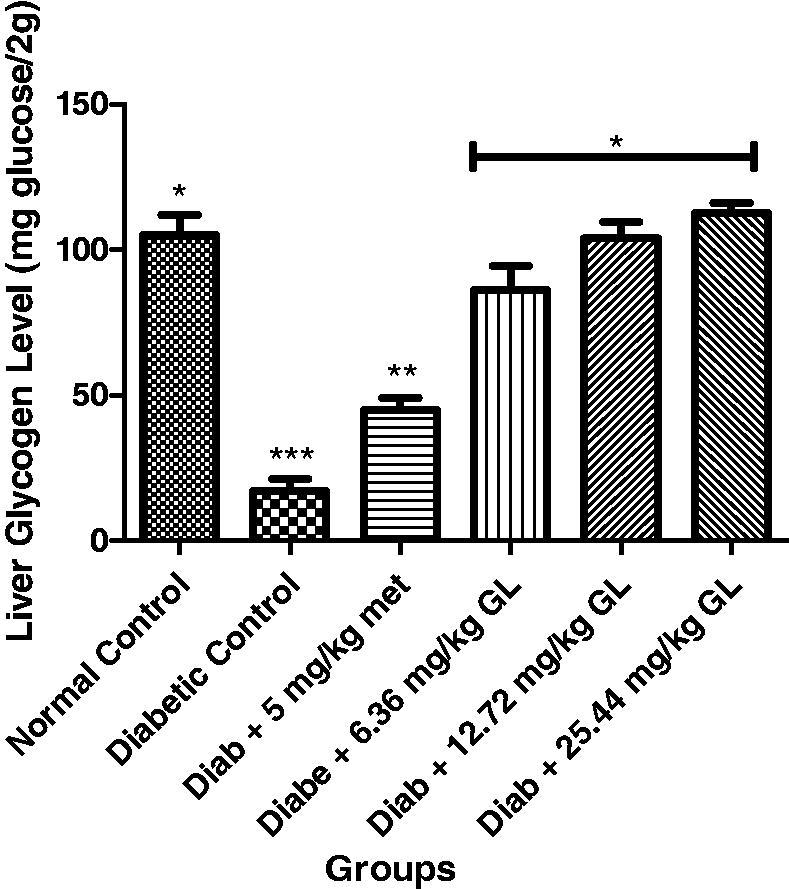
Liver glycogen level in alloxan-induced diabetic rats after administration of aqueous extract of G. latifolium leaf. Values are expressed as mean ± standard deviation (SD) of eight replicates. Bar with the same * are not significantly different at p > 0.05. Bar with different * are significantly different at p < 0.05. Normal control: non-diabetic control; met: metformin; diab: diabetic; GL: Gongronema latifolium leaf.